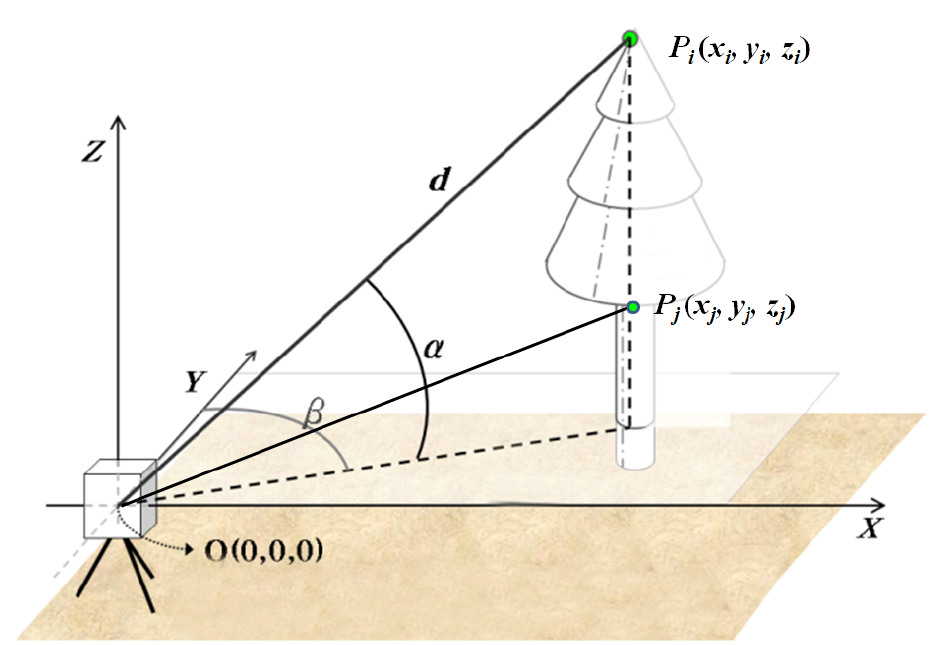
) and crown base height (CBH) ( P i